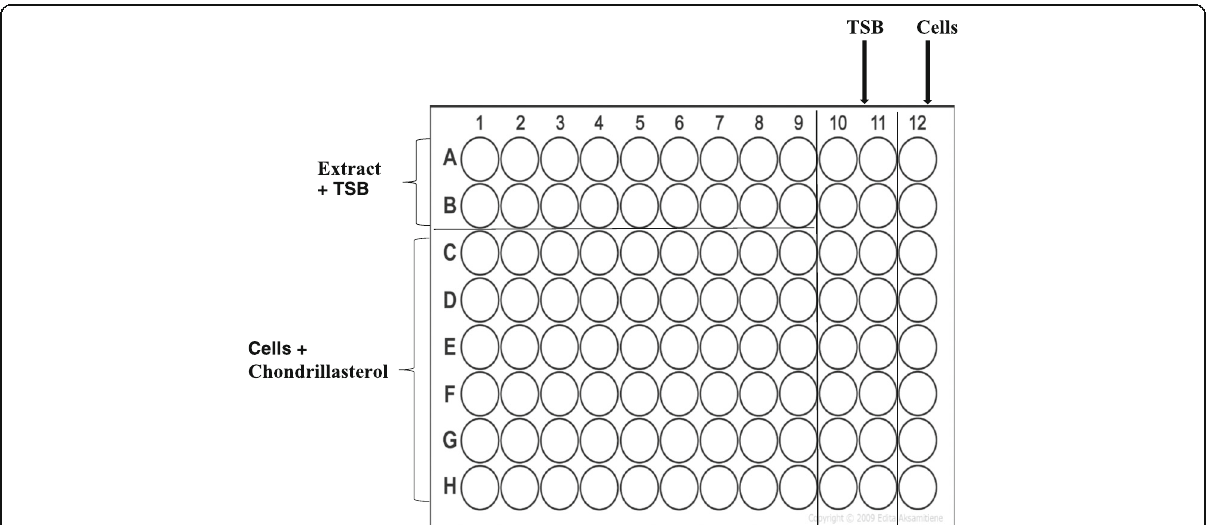
Fig. 1 Plate layout for testing effect of chondrillasterol on mature biofilm. A two-fold serial dilution was carried out for chondrillasterol starting from 200 μ g/mL. Increasing concentrations of chondrillasterol were added starting from column C1. Controls included: (i) the extract being incubated alone (rows 1 and 2), (ii) media alone (column 10 and 11) and (iii) viable bacterial cells incubated alone (column